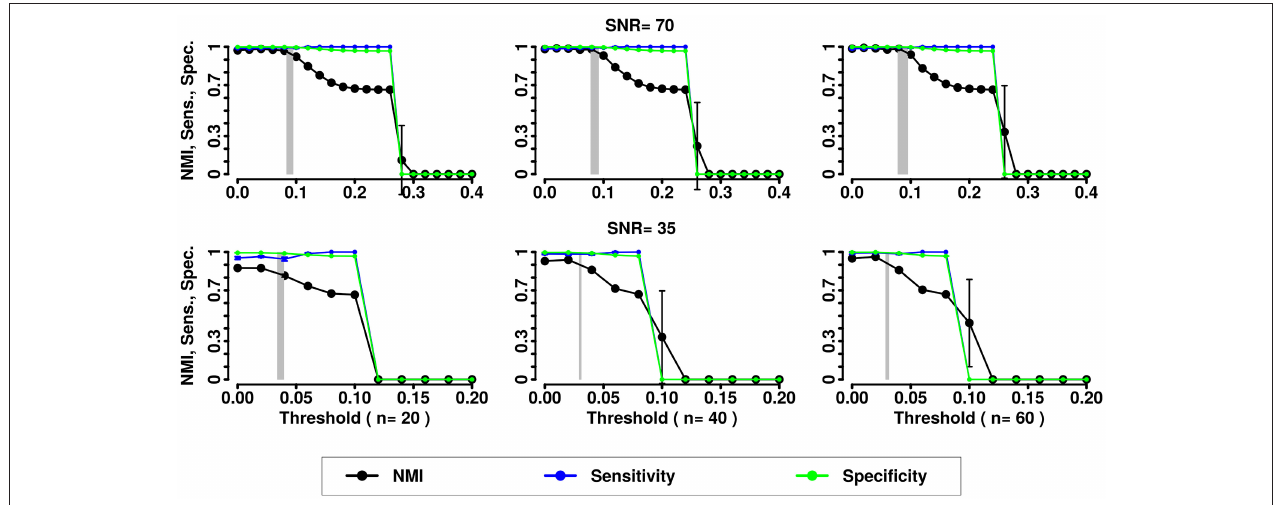
FIGURE 7 | NMI (in black), Sensitivity (in blue), and Specificity (in green) of the Asymptotical Surprise community detection algorithm applied to LFR networks ( µ t = µ w = 0.2). Two different signal to noise ratio (SNR) are represented on the lines (top line SNR = 70, lower line SNR = 35), Number of subjects varies depending of the column (respectively from left to right 20, 40, and 60